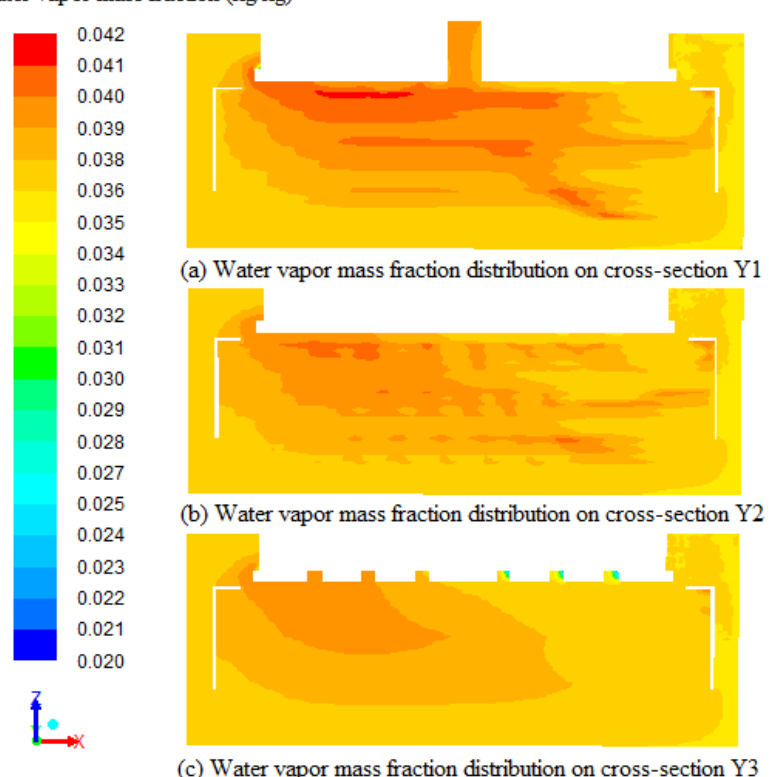
Figure 11. Water vapor mass fraction distributions on the cross-sections (Y1, Y2, and Y3) of the tobacco curing chamber at 108,000 s.